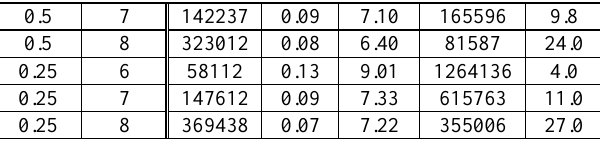
Table 2: Results of LR B-spline surface approximations of the combined bathymetry data set (Figure 4) for various input tolerances and iteration levels